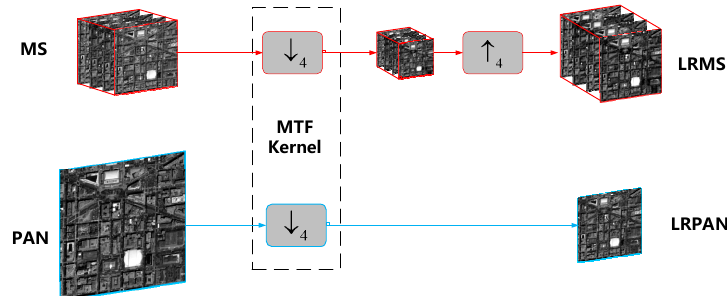
Figure 5. Generation of a training dataset through Wald protocol.